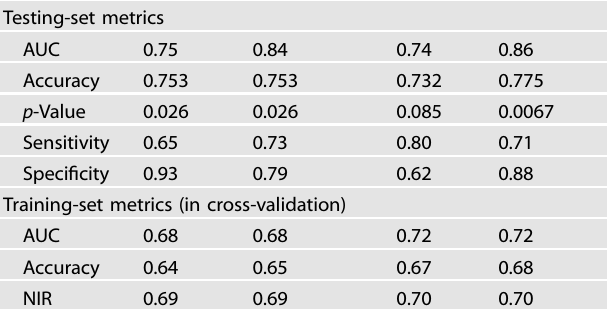
Model testing . Using the “ metabolomics models ” feature set, the best-trained classi fi ers predicted response to combination anti-